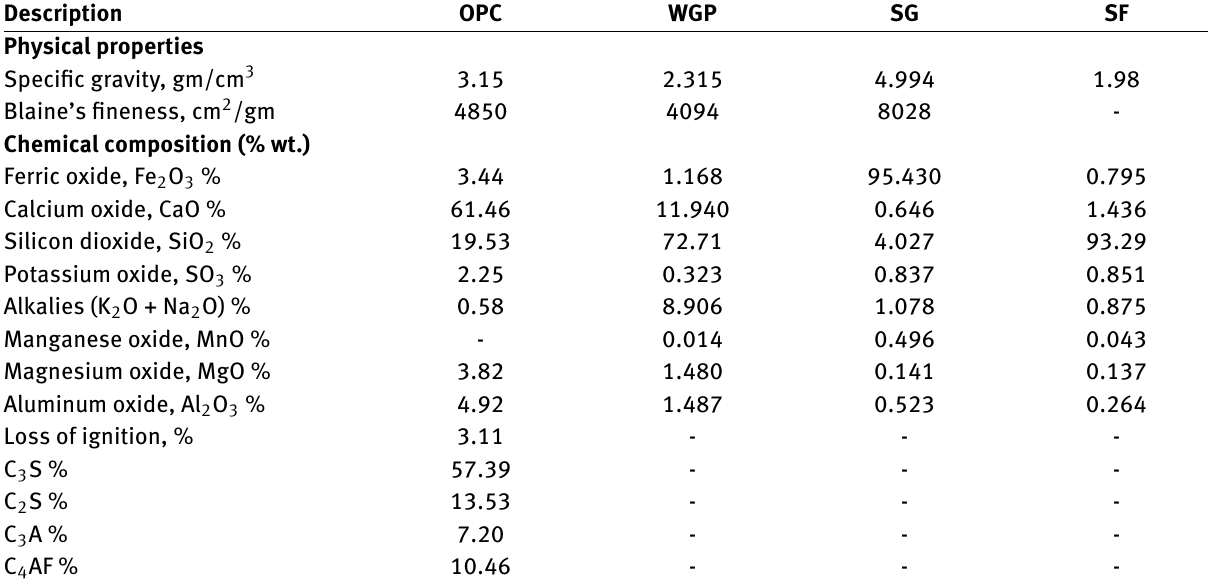
Table 1: Physical properties and Chemical composition of the OPC, WGP, SG and SF.